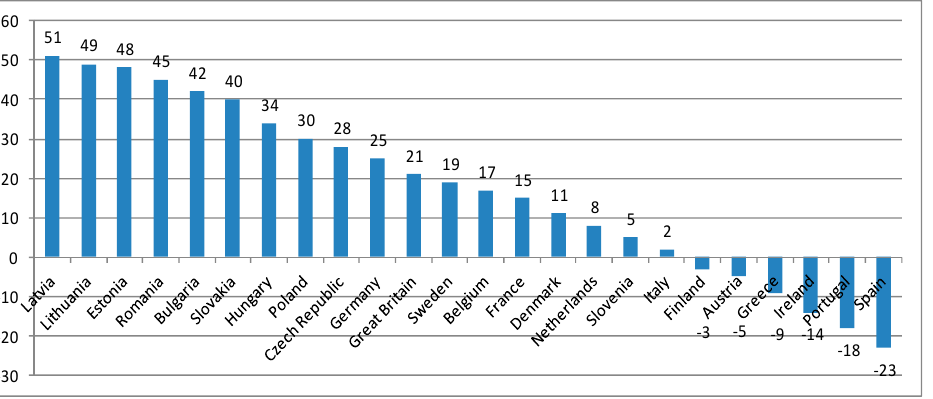
Figure 12. Implementation of greenhouse gas reduction commitments by 2030. Implementation status in 2018 (in terms of percentage) [41,52].